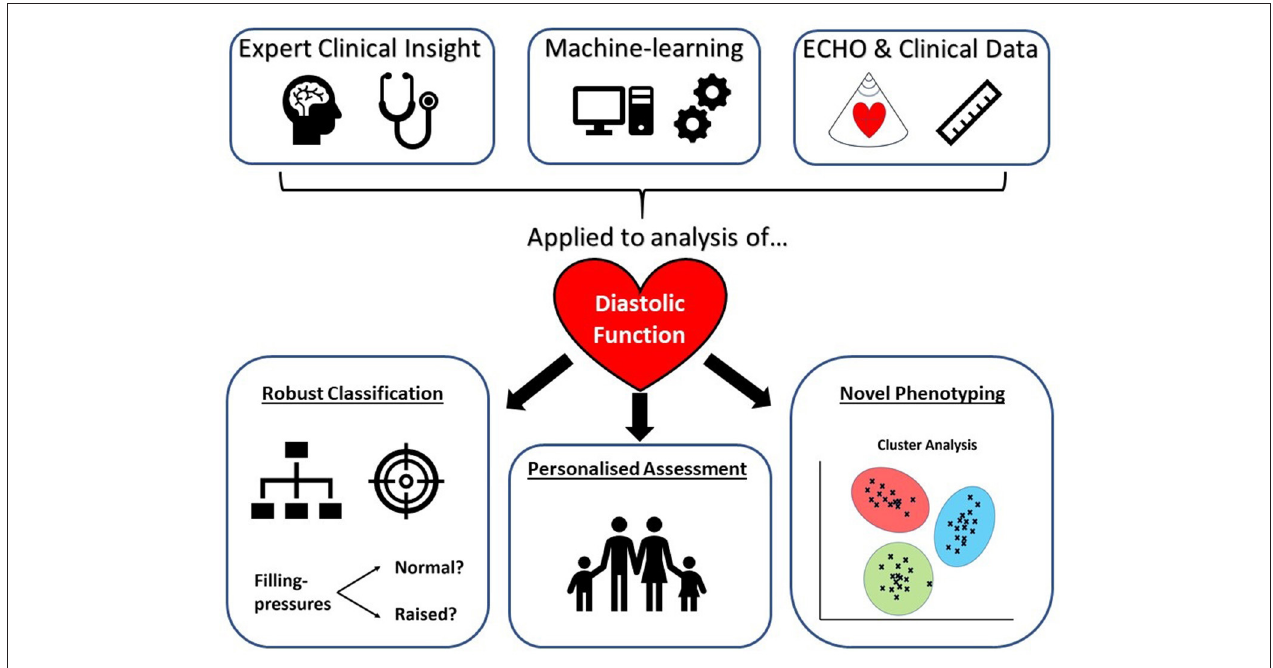
FIGURE 1 | Machine learning augmented diastolic function assessment with